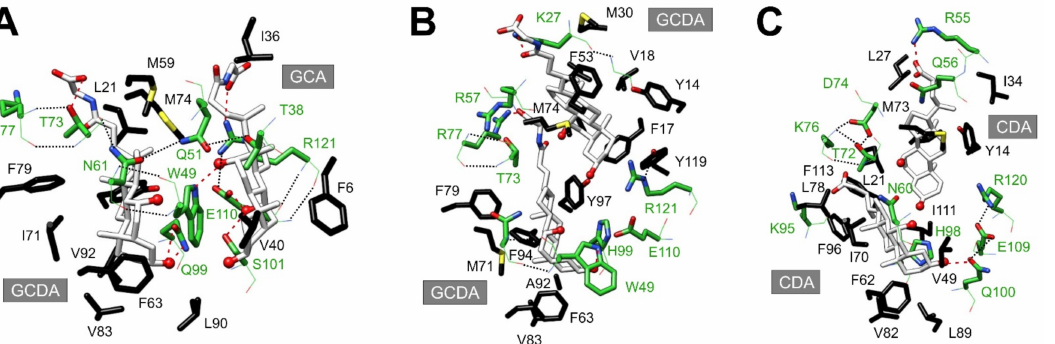
Figure 4. Stabilizing H-bond and hydrophobic interactions in the binding pocket of ( A ) human ileal (PDB: 2mm3 [25]), ( B ) chicken ileal (PDB: 2lba [51]), and ( C ) chicken liver (PDB: 2jn3 [40]) BABPs. Backbone and side chain atoms of residues with a polar side chain (green) are shown as lines and sticks, respectively. Hydrophobic amino acid side chains interacting with the apolar face of the bound bile salts are shown in black. Intermolecular (red) and intramolecular (black) H-bonds are indicated by dotted lines. Steroid ring OH-groups of bound bile salts are shown as red balls. Color coding: C-atoms in green (protein, polar residues), black (protein, apolar residues), or white (bile salts), O-atoms in red, N atoms in blue, S-atoms in